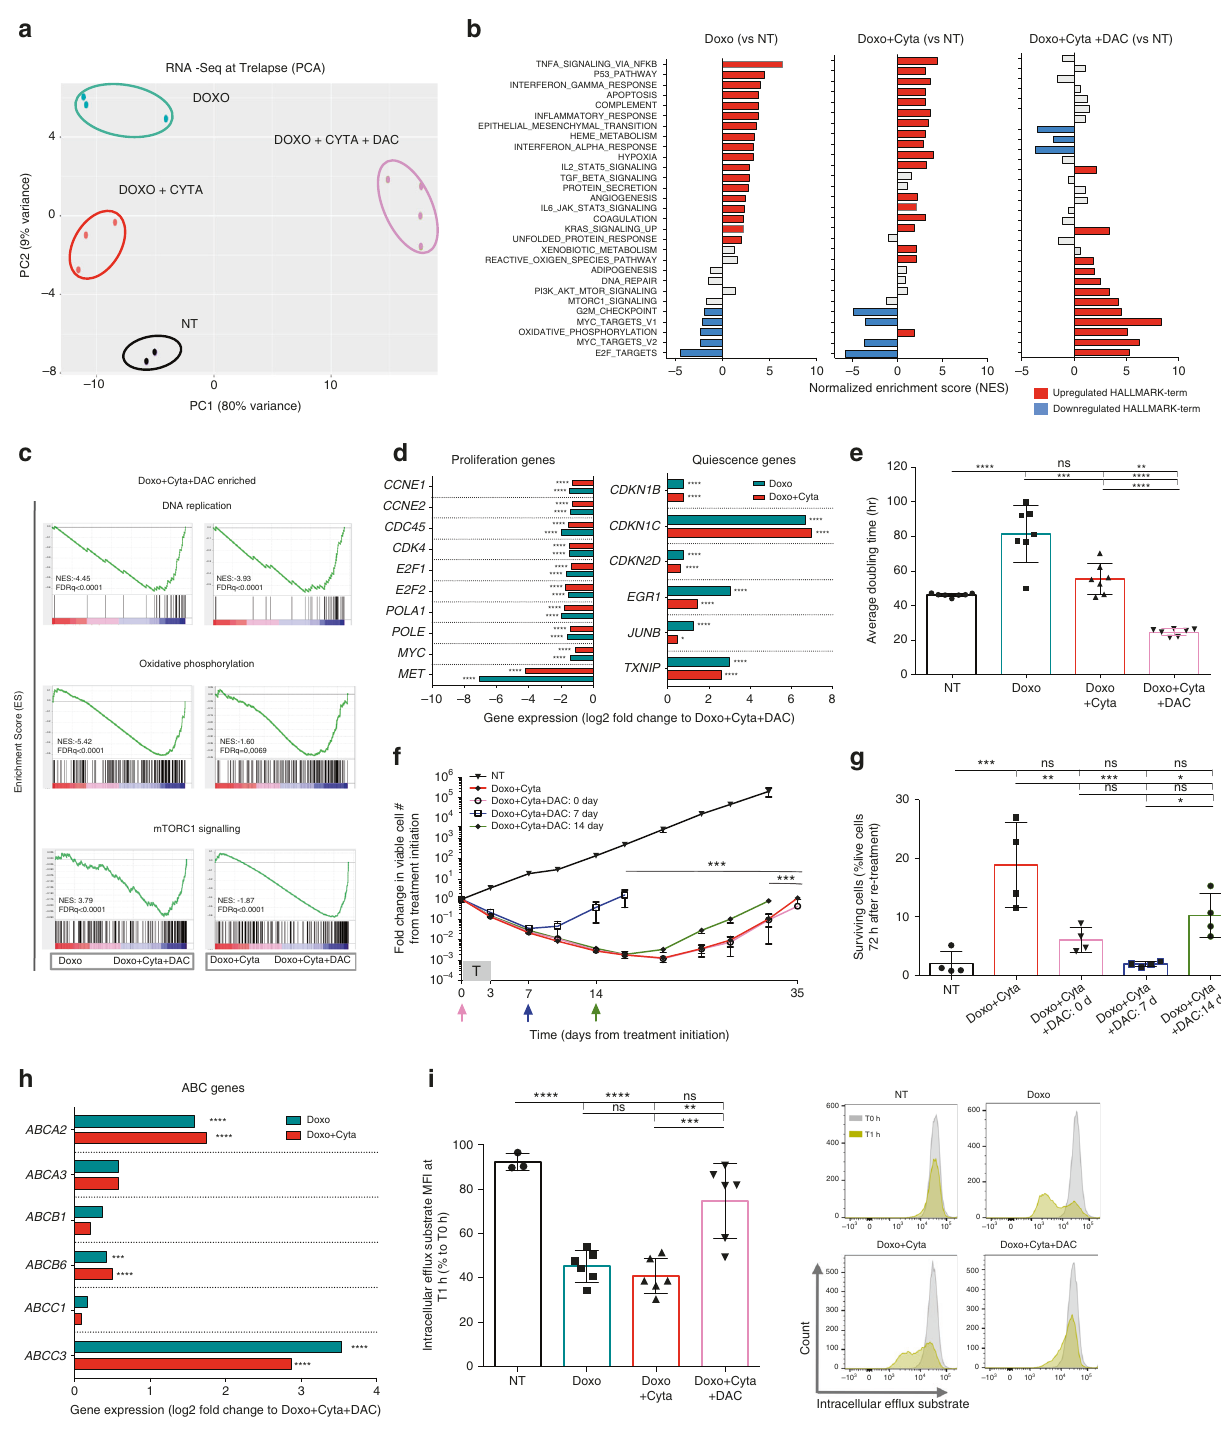
also observed increased expression of pathways related to meta- bolism such as mTORC1 signaling 32 and oxidative phosphor- ylation, suggesting an overall increase in proliferative and biogenesis capacity of Doxo + Cyta + DAC relapses compared to both NT and Doxo ± Cyta groups, further re fl ecting the higher clonal expansion observed in Doxo + Cyta + DAC relapses. In strike contrast, Doxo ± Cyta samples showed not only a decrease in proliferative pathways, but an enrichment in pro-in fl ammatory pathways together with an up-regulation of the hypoxia pathway